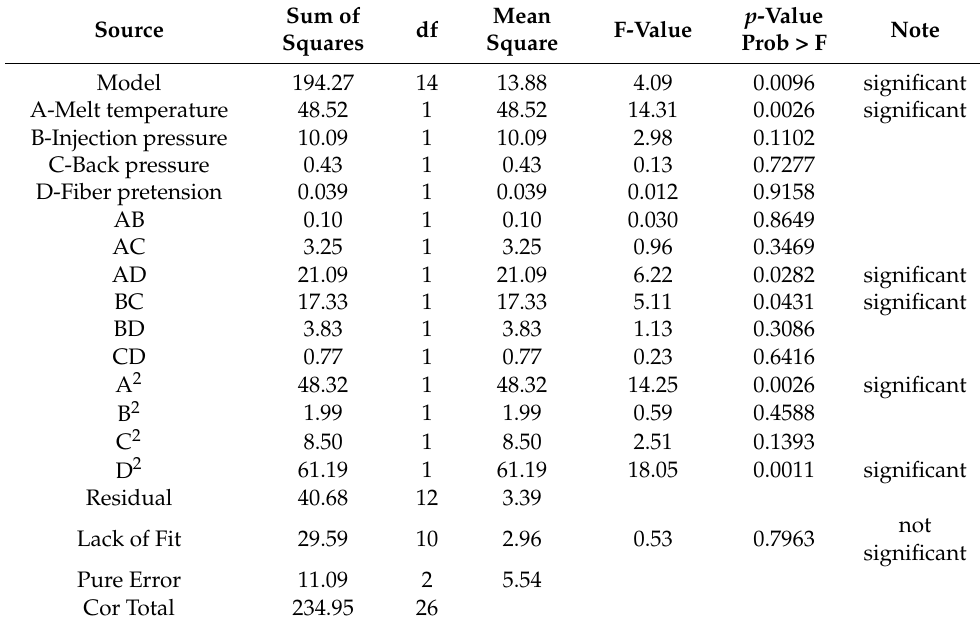
Table 8. ANOVA for flexural